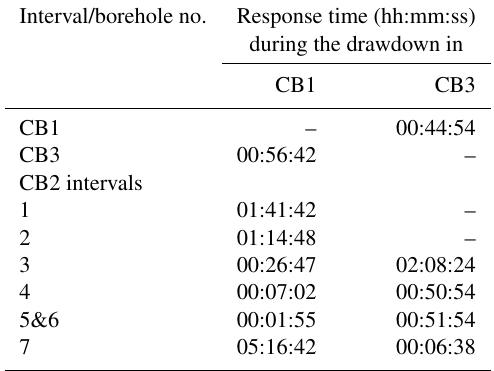
Table 3. Characteristic pressure response time in the monitored boreholes/intervals during the drawdowns. Interval/borehole